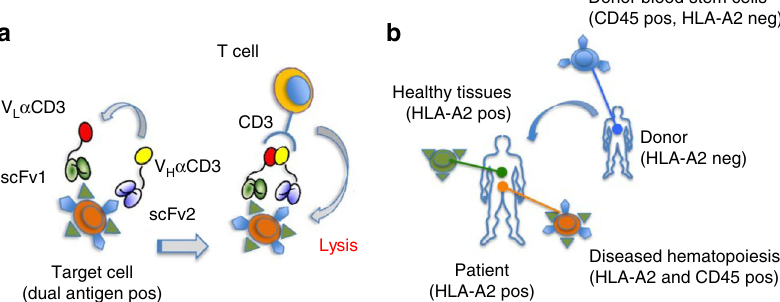
Fig. 1 Combinatorial immunotherapy by hemibodies. a Binding of two hemibodies to their respective antigens on a target cell, each consisting of a single- chain variable fragment (scFv) fused to the variable light (V L ) or variable heavy chain domain (V H ) of a CD3-speci fi c antibody, enables V H /V L association and the reconstitution of a functional CD3-binding site to engage T cells. b Allogeneic mismatch transplantation model: The hematopoietic system of a HLA-A2-positive leukemia patient is replaced by blood stem cells of an HLA-A2-negative donor. Hemibodies directed against HLA-A2 and the pan- hematopoietic marker CD45 tag the patient ’ s dual antigen-positive diseased hematopoiesis for lysis by T cells, while sparing single antigen-positive healthy tissues and donor-derived blood